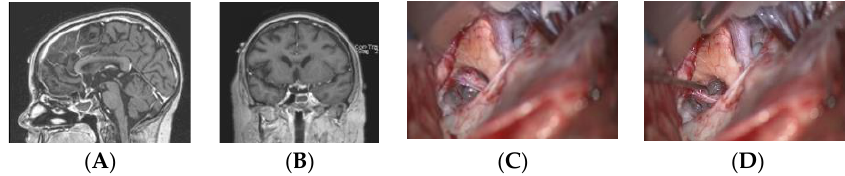
Figure 8. Twelve-year-old girl with suprasellar tumor with β -HCG. Following chemotherapy, the β -HCG was normalized, but there was a small contrast-enhancing lesion in the left suprasellar location on MR (sagittal ( A ) and coronal ( B ) views). Surgical photographs at second-look surgery demonstrate the chiasm and an atrophic but continuous pituitary stalk ( C ), which is retracted by a hook ( D ). The lesion demonstrated no viable cells.